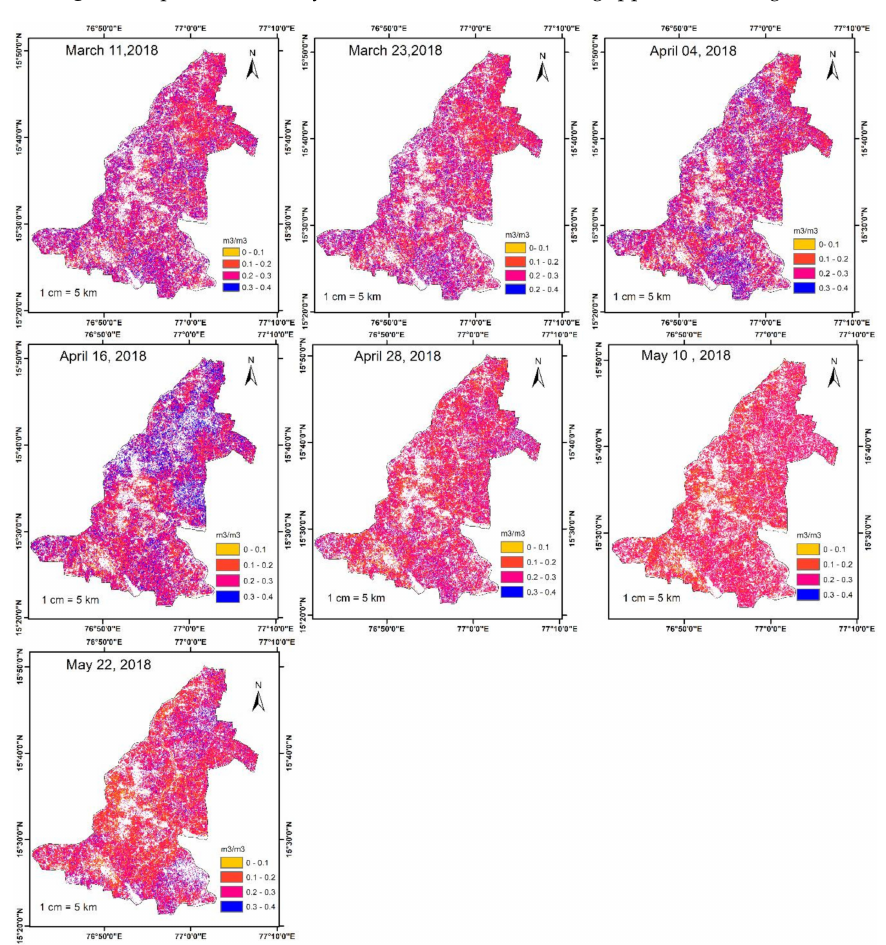
Figure 10. Spatial variability in the soil moisture in Siruguppa taluk during